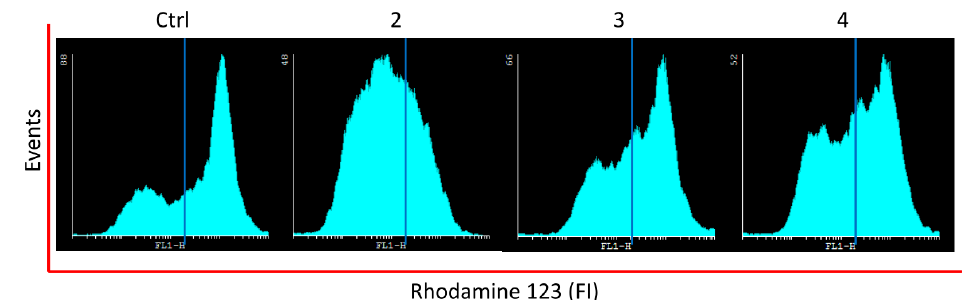
Figure 3. Effect of treatment with compounds 2 – 4 in mitochondrial membrane permeability in MCF-7 cell line was analyzed by flow cytometry. Cells were treated with compounds (25 µ M), posteriorly stained with rhodamine 123 and then analyzed by flow cytometry. Representative histogram showing changes of mitochondrial membrane permeability.